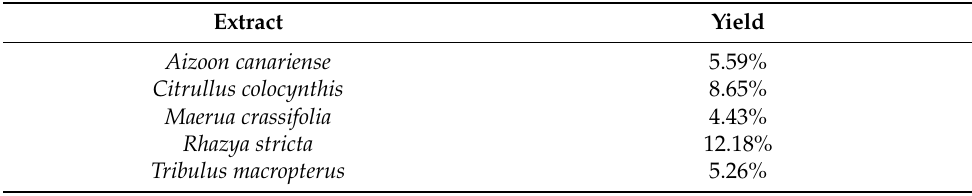
Table 1. The yield of the different plant extracts following the plant material extraction process with methanol for 72